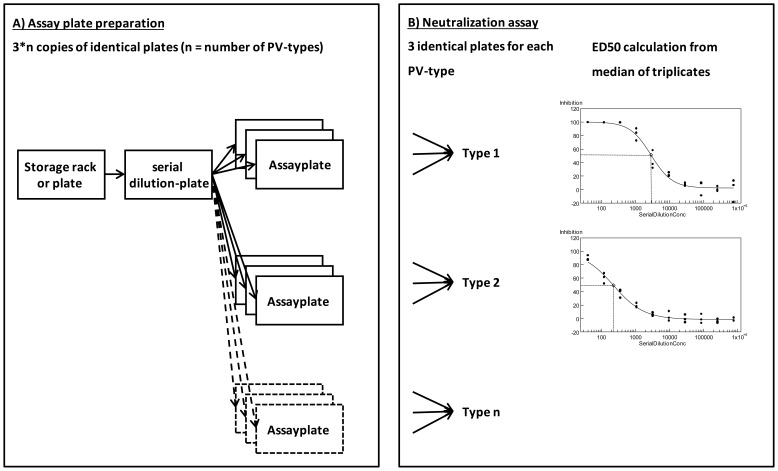
HT-PBNA protocol.Assay plate preparation (A) and neutralization assay (B) are separated. In a first step, serial dilutions of serum samples are performed on one dilution plate. Identical assay plates are generated by transferring the dilutions to multiple replica-assay plates which can be stored at −20°C. In the second step, the neutralization assay is carried out in a add-on format using the previously prepared assay plates. A) Assay plate preparation. Sera are transferred from a 96 well storage in SBS standard to a 384 well polypropylene V-bottom plate for serial dilution with a pipetting robot in cell culture medium. Finally the serially diluted sera are transferred with the same pipetting robot to each of 3*n white 384 well cell culture assay plates (n = number of PV-types). The plates are sealed immediately with a cover foil and stored at −20°C until their use in the PBNA. B) Assay assembly and read out. Assay plates are thawed and pseudovirions followed by reporter cells are added with a bulk dispenser. Three identical assay plates originating from the same serum dilution plate are used for each PV- type. After 2 days of incubation the luminescence from the Gaussia reporter is read directly in the assay plates. Inhibition (%) is calculated by normalization of the luminescence to the mean of the negative control wells without serum present on each plate. The median of the triplicate values is used for the calculation of the ED50-value (effective dilution giving 50% inhibition) for each serum according to the four parameter logistic curve fit model y = A+(B−A)/(1+(C/x)∧D).